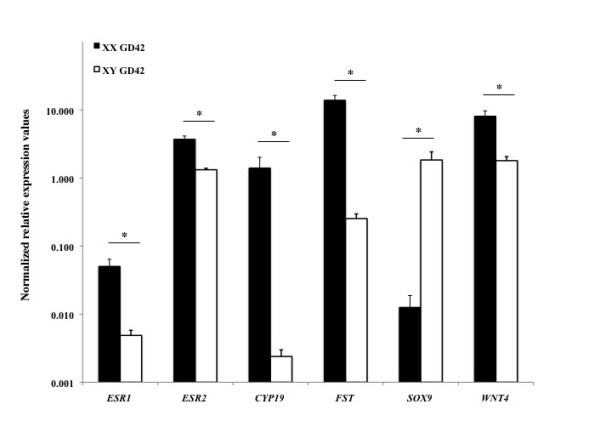
Relative expression level of ESR1, ESR2, CYP19A1, FST, SOX9, and WNT4 in GD42 ovaries and testes according to real time PCR analysis. ESR1, ESR2, CYP19A1, FST, and WNT4 were significantly (asterisk, P < 0.05) higher expressed in GD42 ovaries, whereas SOX9 was significantly (asterisk, P < 0.05) higher expressed in GD42 testes. The y-axis indicates mean 2-ΔCp values (± SEM) according to Schmittgen and Livak, 2008 [33].